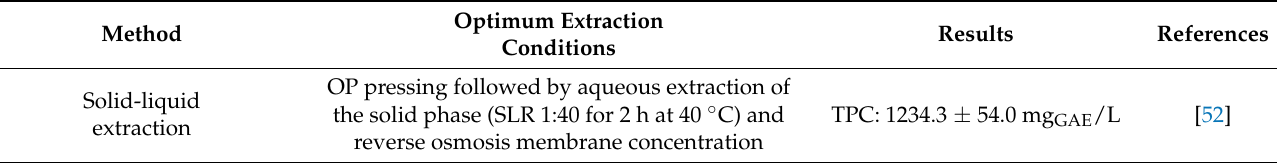
Table 3. Different extraction methods applied to